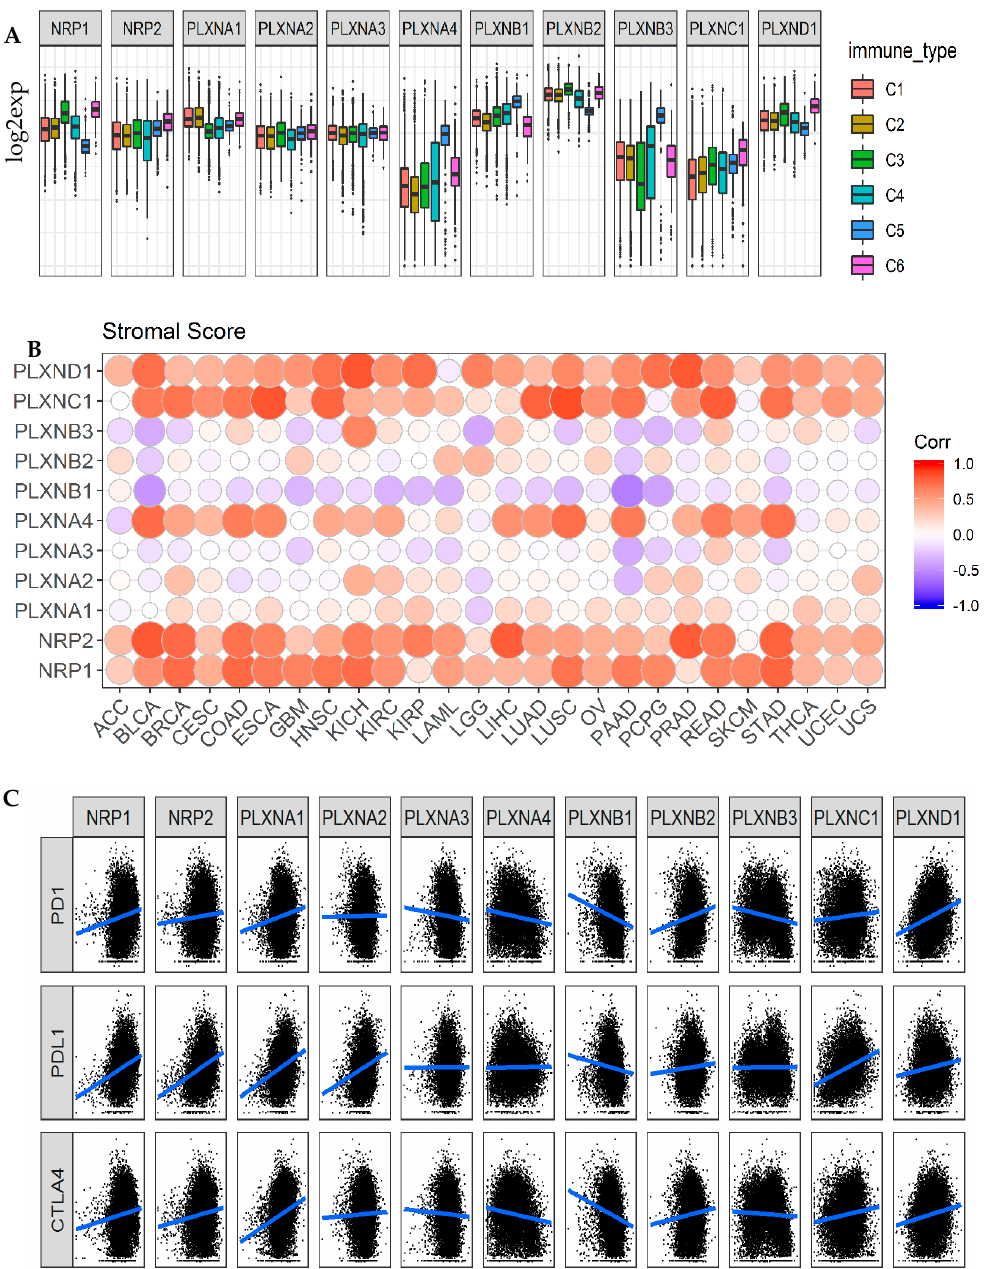
Figure 4. Association of NRP and PLXN family gene expression with tumor microenvironment factors. ( A ). The expressions of NRPs and PLXNs within di ff erent immune infiltrate subtypes across all the cancer types tested with ANOVA. C1: wound healing, C2: INF-r dominant, C3: inflammatory, C4: lymphocyte depleted, C5: immunologically quiet, and C6: TGF β -dominant. p < 1 / (11 genes × 6 subtypes) = 0.015 as significance. ( B ). Correlation matrix plots to show the association between expressions of NRPs and PLXNs and stromal scores of 25 di ff erent cancer types based on ESTIMATE algorithm. Spearman correlation was used for testing. The size of the dots stands for the absolute value of the correlation coe ffi cients. The bigger the size is, the higher the correlation is (higher absolute correlation coe ffi cient). This also applies to Figure S3A,B. p < 1 / (11 genes × 26 cancer types) = 0.0034 as significance. ( C ). Scatter plots to show the correlation between the expression of NRPs and PLXNs with that of immune checkpoint molecules PD1 / PDL1 and CTLA-4. Spearman correlation was used for testing. p < 1 / (11 genes × 3 immune blockade molecules) = 0.03 as